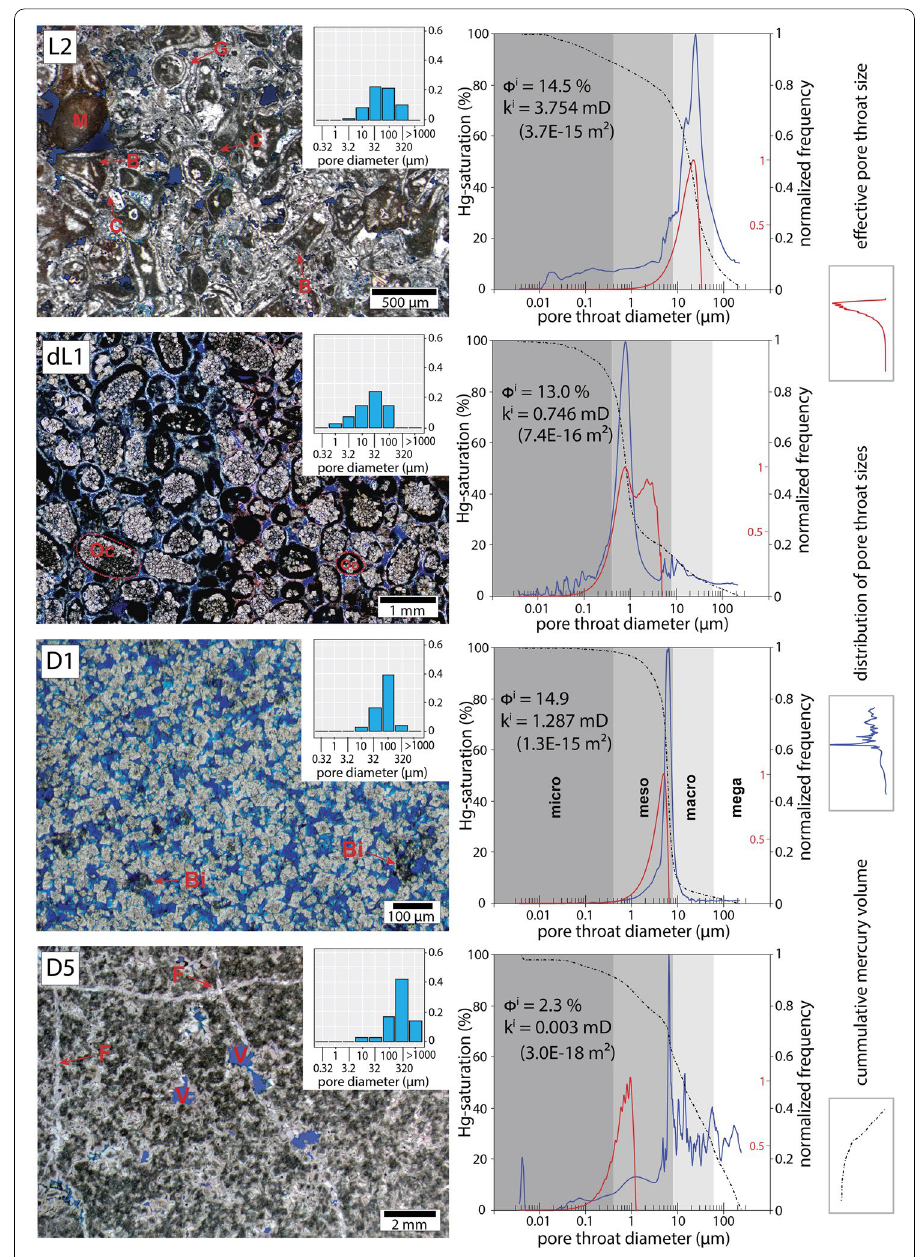
Fig. 4 Overview of the litho-types limestone (L2), dolomitic limestone (dL1), and dolostone (D1, D5), typically occurring in the carbonate sequence of the Upper Jurassic Malm reservoir. Images are from thin sections of the studied samples, pore size distributions are from digital image analysis, and pore throat diameters were measured by mercury intrusion porosimetry (MIP). See text for summarized description and Appendix 1